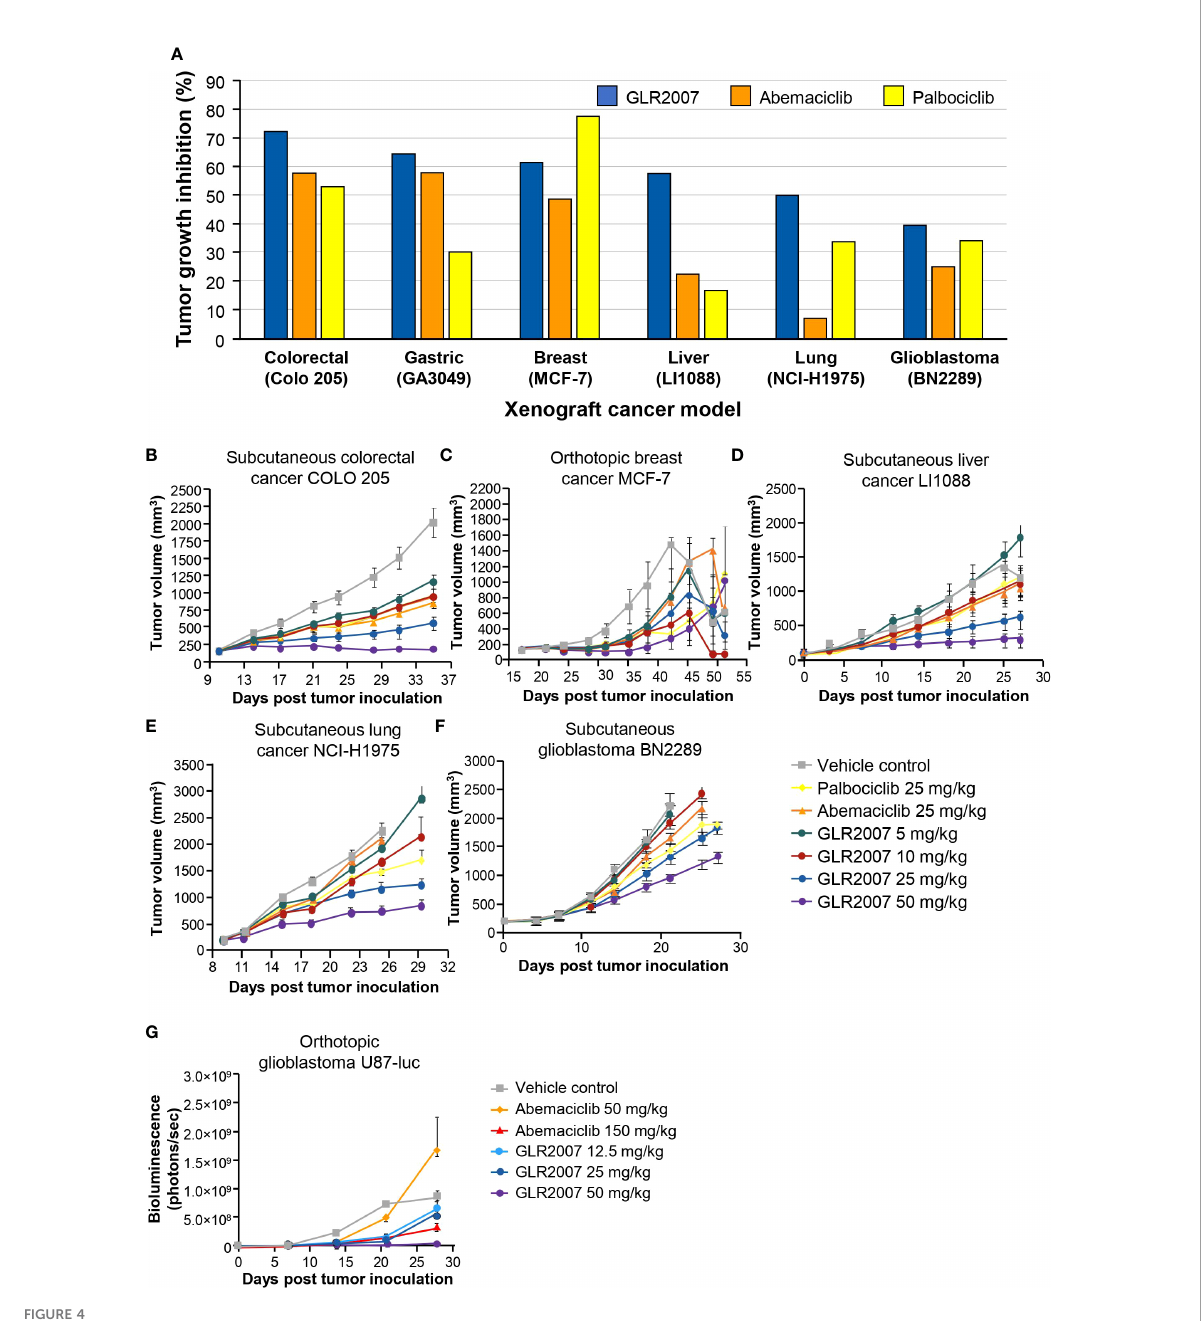
FIGURE 4 Tumor growth inhibition in mouse xenograft models treated with GLR2007, abemaciclib, and palbociclib. (A) Tumor growth inhibition in mouse xenograft cancer models following treatment with 25 mg/kg body weight of GLR2007, abemaciclib, and palbociclib, compared with vehicle control. (B – F) Tumor growth curves of mouse xenograft cancer models. (B) Subcutaneous colorectal cancer COLO 205, treated for 26 days, measured on day 25. (C) Orthotopic breast cancer MCF-7, treated for 28 days, measured on day 25. (D) Subcutaneous liver cancer LI1088, treated for 28 days, measured on day 25. (E) Subcutaneous lung cancer NCI-H1975, treated for 26 days, measured on day 16. (F) Subcutaneous glioblastoma BN2289, treated for 22 – 28 days, measured on day 21. (G) Tumor growth curve re fl ected by bioluminescence density of orthotopic glioblastoma U87-luc, treated for 42 days with a range of doses of GLR2007 or